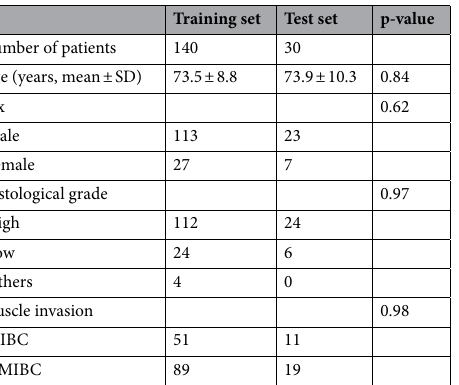
Table 1. Patient characteristics. SD standard deviation, MIBC muscle-invasive bladder cancer, NMIBC non- muscle-invasive bladder cancer.